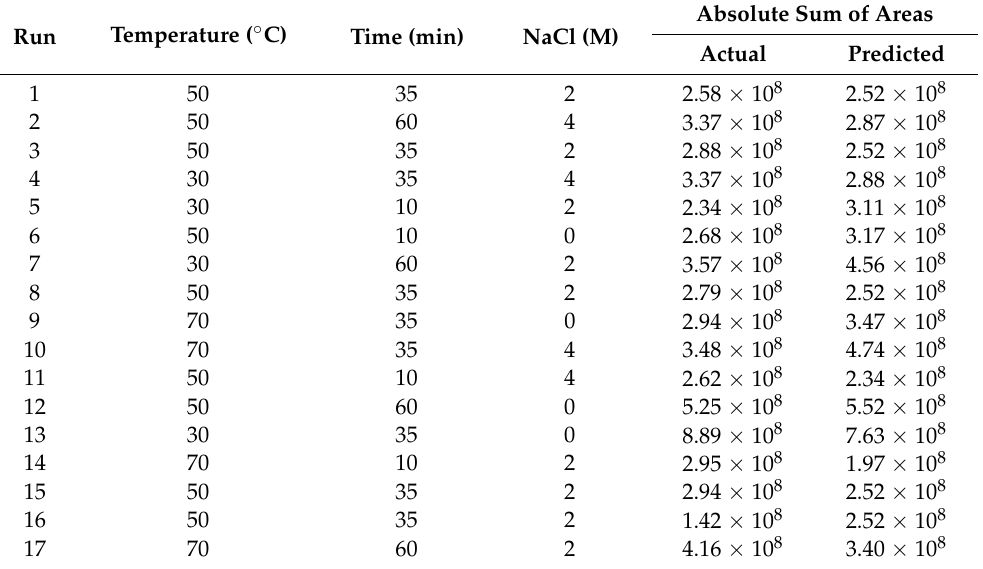
Table 3. Combinations of experiment conditions of the BBD and the measured and predicted absolute sum of areas of common volatile compounds in pineapple core.